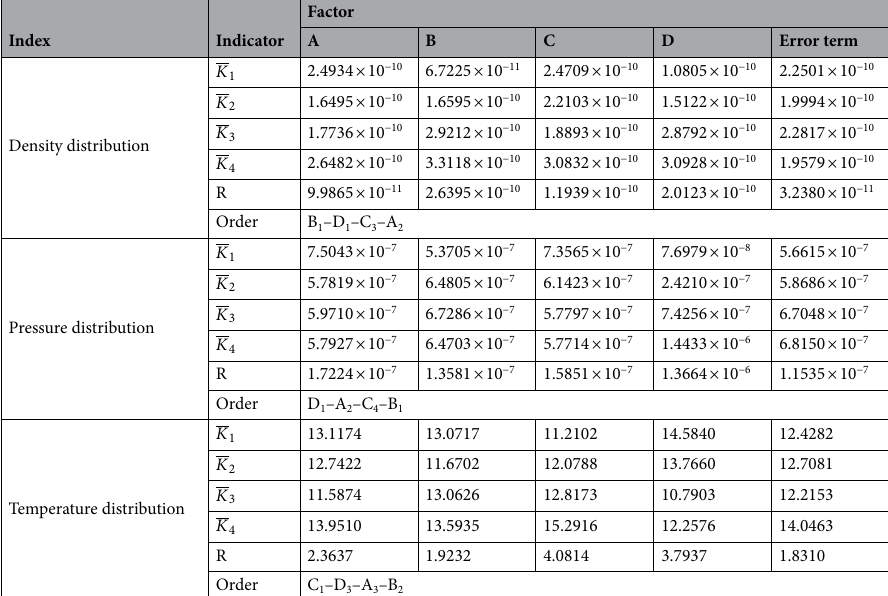
Table 3. Optimal combination of process parameters with single